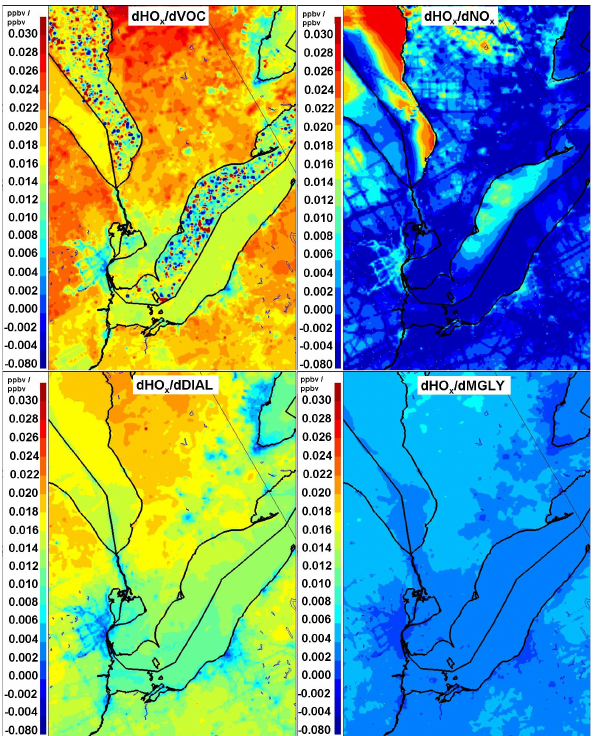
Fig. 23. Change in HO x after a two-minute timestep relative to change in (a) VOCs, (b) NO x , (c) Dialdehydes, and (d) Methylgly-